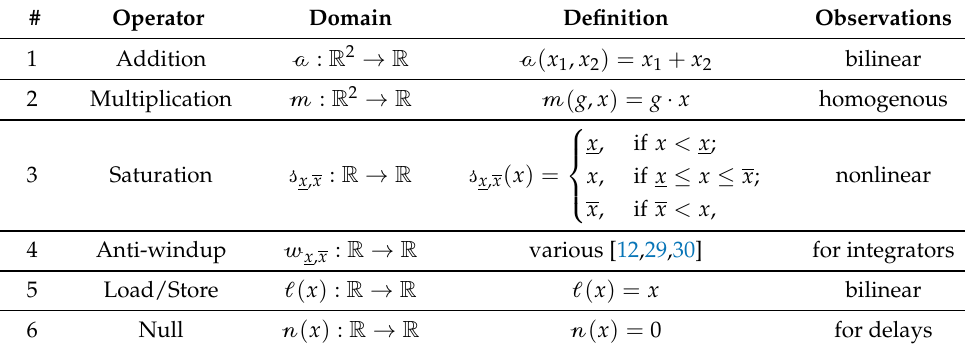
Table 1. Formal operators necessary for the implementation of LTI-based control